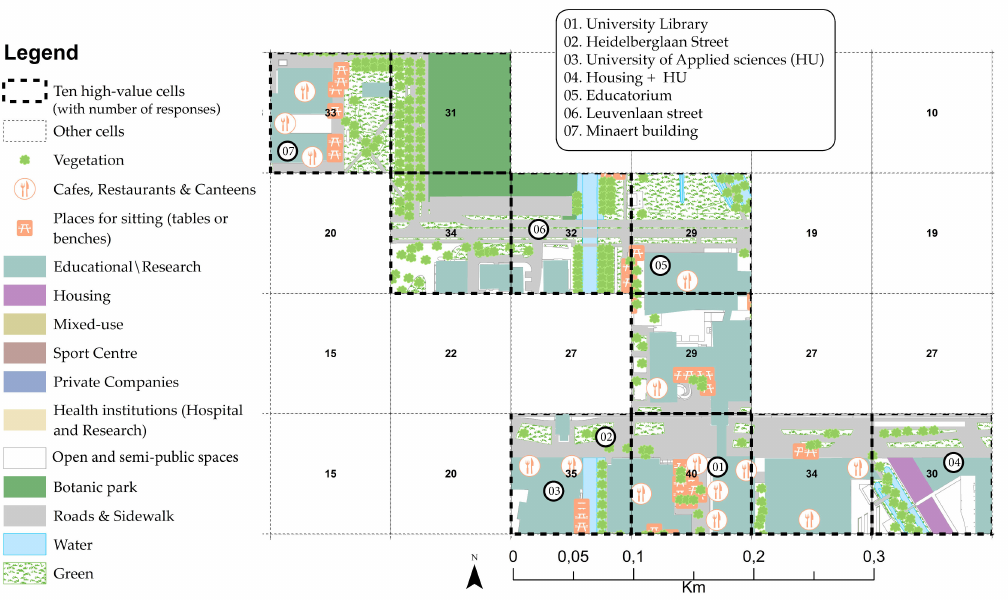
Figure 14. Ten high-value cells at